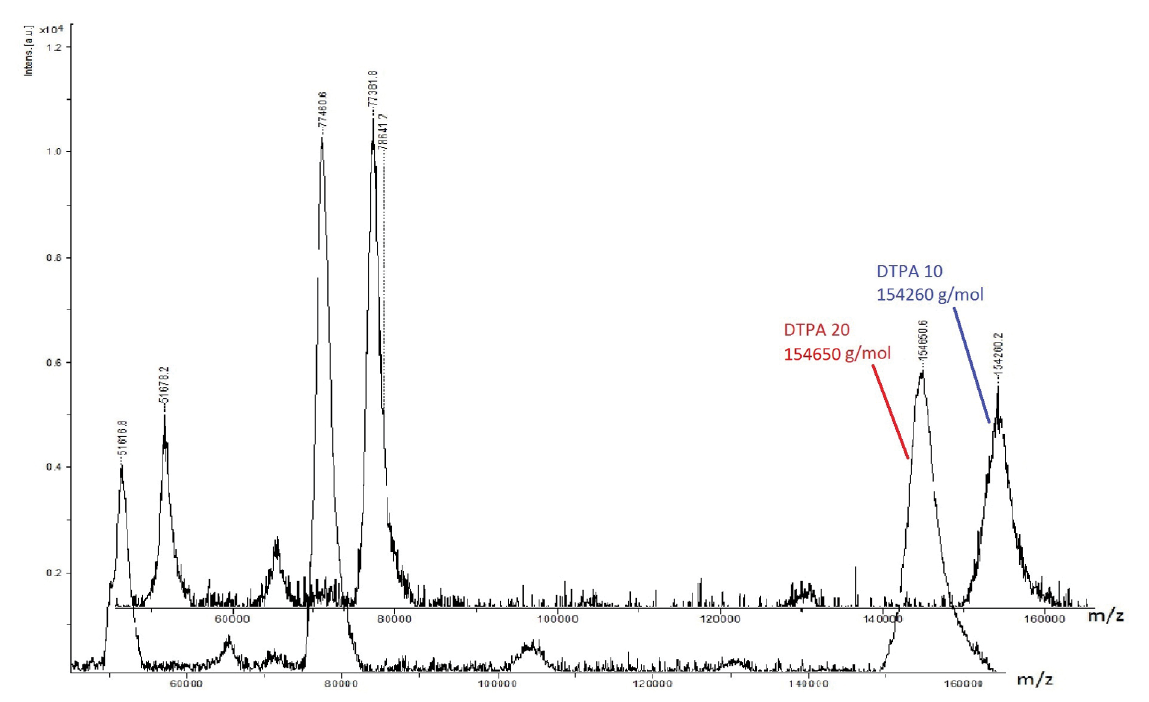
FIGURE 5 - MALDI/TOF immunoconjugate spectrum (spectrometer Bruker Autoflex Speed, CEFAP ICB / USP). Molecular weight